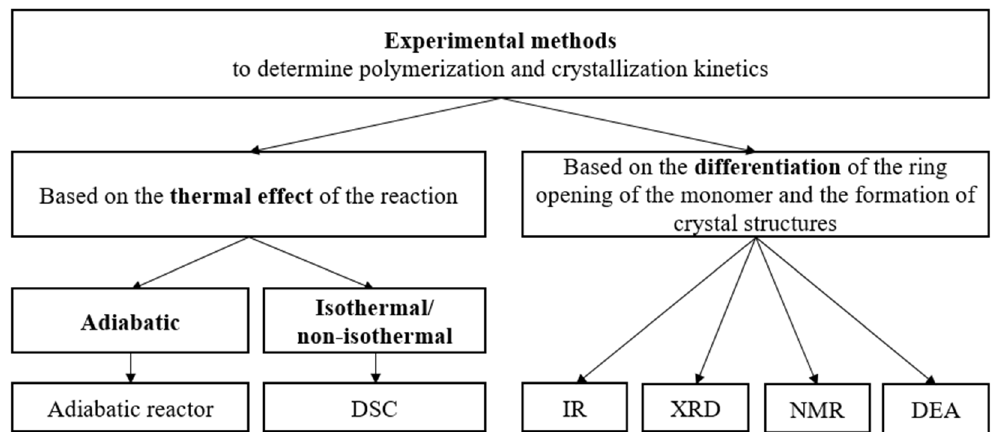
Figure 6. Experimental methods for determining the polymerization and crystallization kinetics of AROP of CL.